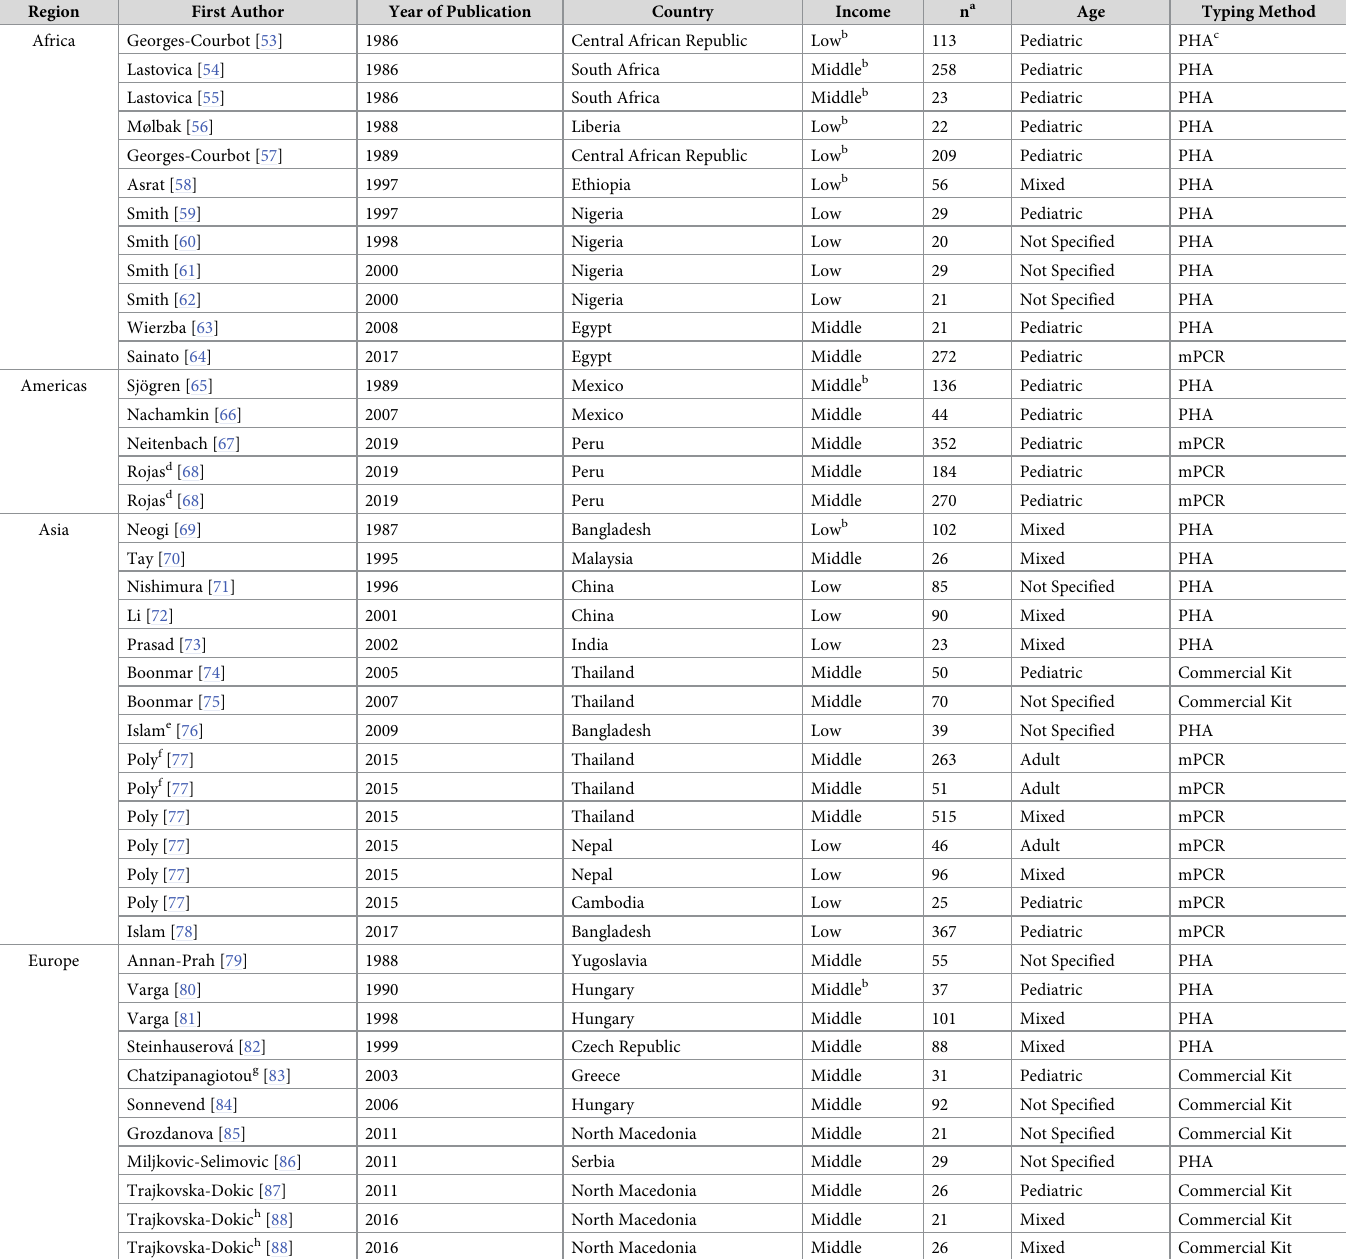
Table 1. Detailed characteristics of observations included in the meta-analysis.